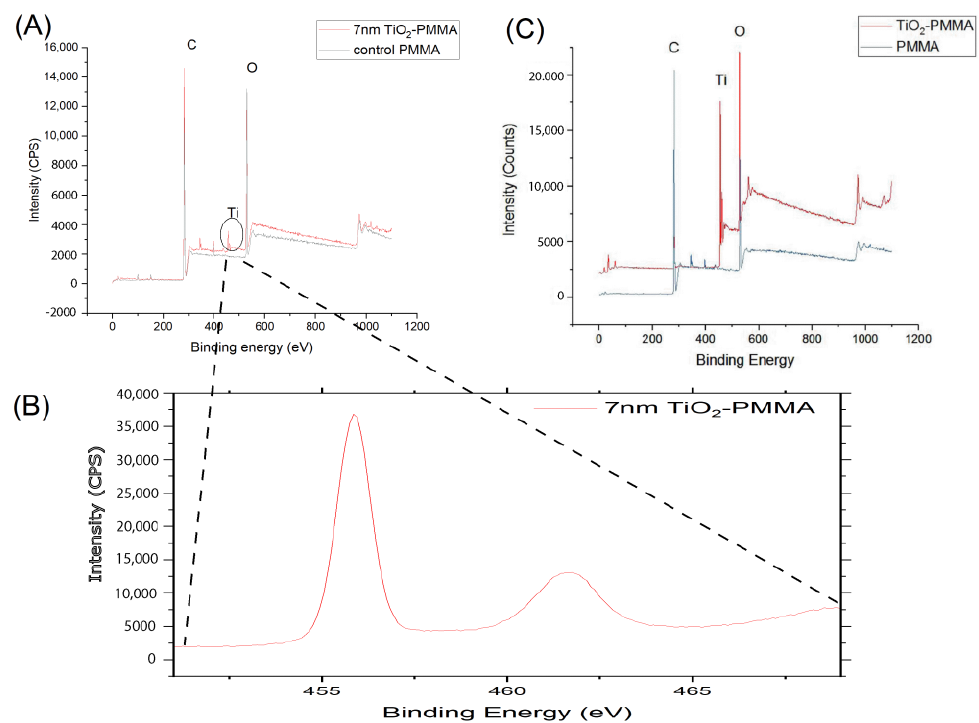
Figure 4. ( A ) XPS survey of PMMA before and after 7 nm ALD-TiO 2 using the same recipe given in Section 2.2.2. ( B ). High-resolution XPS scan of 7 nm TiO 2 coated PMMA sample between 440 to 470 eV. ( C ). XPS survey of PMMA before and after 30 nm. ALD-TiO 2 using the same system and recipe given in Sections 2.2.1 and 2.2.2 respectively